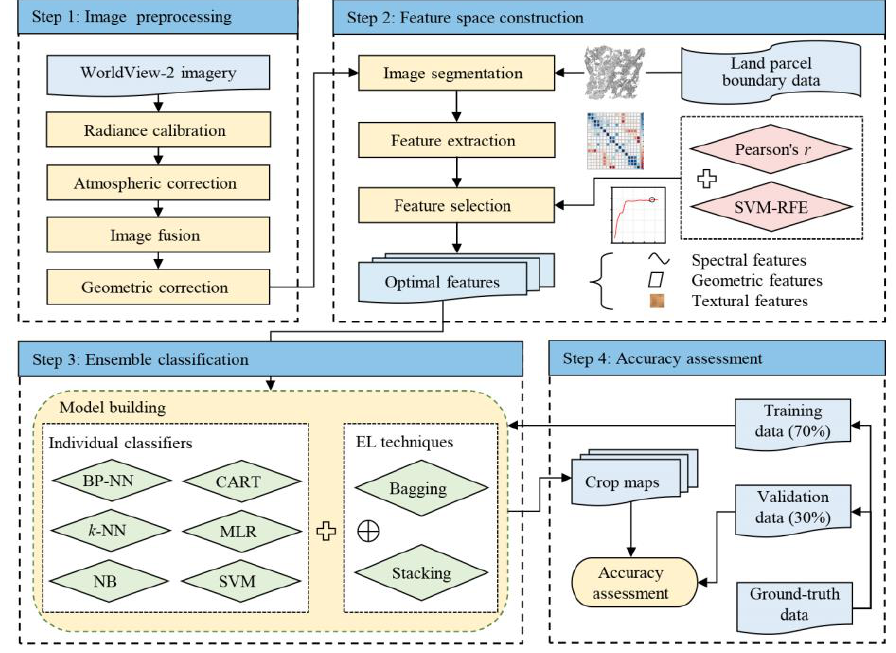
Figure 3. Crop mapping framework supported by EL technology.